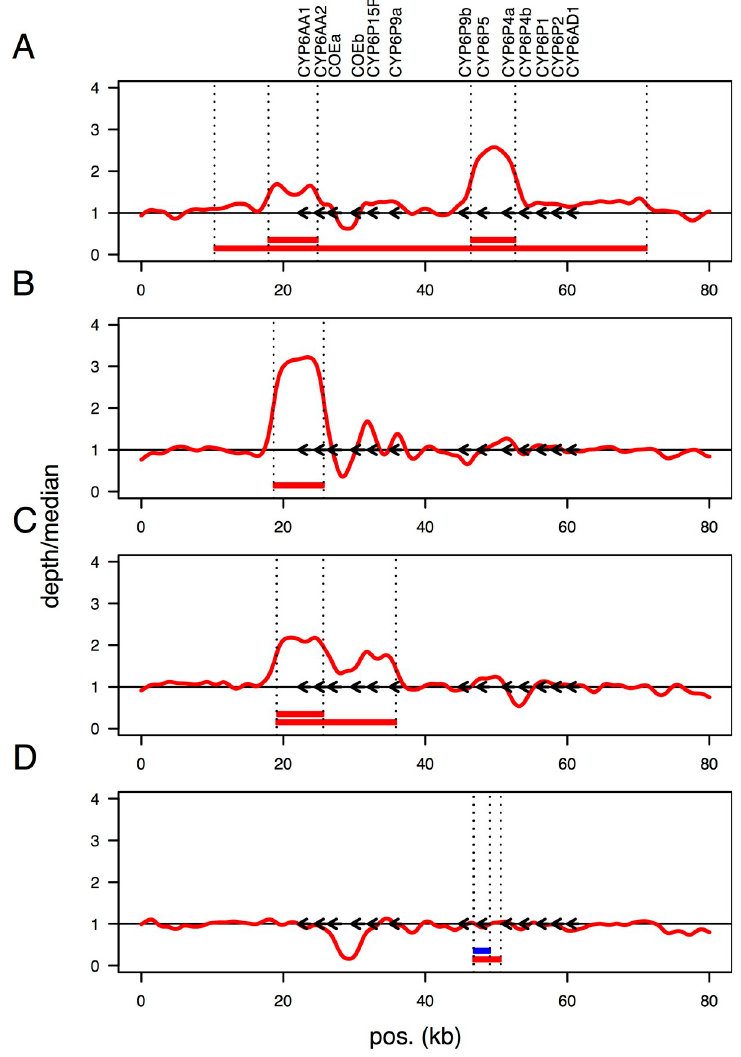
Fig 4. Structural polymorphism in the CYP6 cluster. Coverage depth, relative to the genome-wide median, across the CYP6 cluster for pooled population samples from (A) Obuasi, Ghana, (B) Kpome, Benin, (C) Mebellon, Cameroon and (D) Kinshasa, DRC. Red lines show the kernel-smoothed coverage depths. The horizontal black line indicates coverage depth equal to the genome-wide median. Arrows indicate locations of genes in the CYP6 cluster (labelled at the top). Horizontal red bars indicate tandem duplications confirmed by identification of breakpoints (vertical dotted lines) and the blue bar indicates a deletion. Positions (‘pos’, in kb) refer to the rp1 BAC